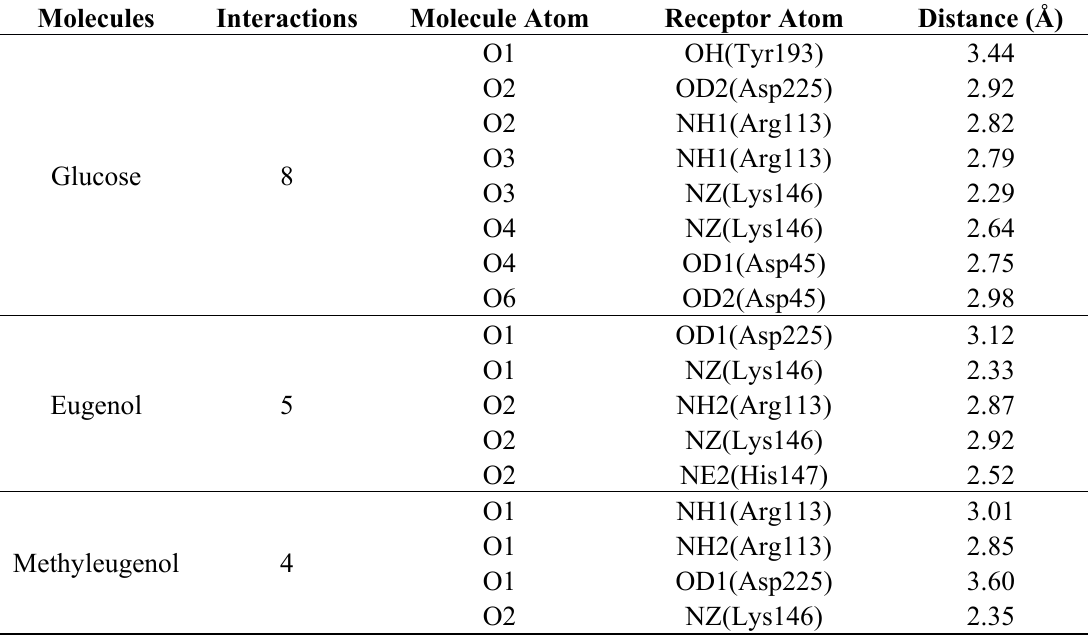
Table 4. Hydrogen bond interactions selected by H-bond score.